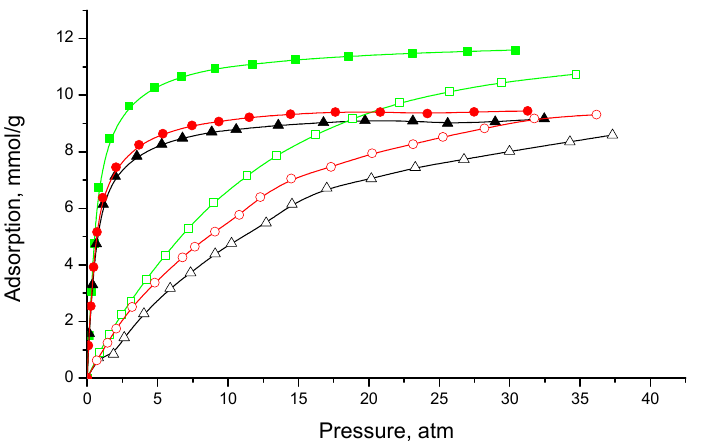
Figure 3. Adsorption isotherms for the 5mw ( ■ ), 1mw ( ● ) and 1solv ( ▲ ) materials at 298 K. Hollow symbols—methane adsorption, solid symbols—ethane adsorption.